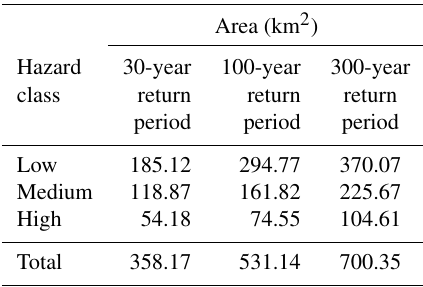
Table 7. The hazard classes for each return period in terms of area